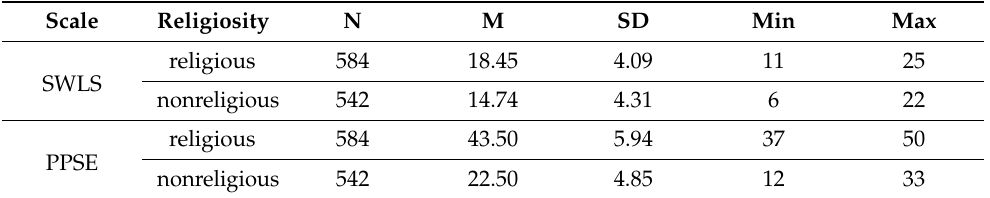
Table 1. Descriptive statistics of well-being (SWLS) and experience of pastoral and psychological service (PPSE) score based on non/religious affiliation in the Czech health population. Scale Religiosity N M SD Min Max religious 584 18.45 SWLS nonreligious 542 PPSE